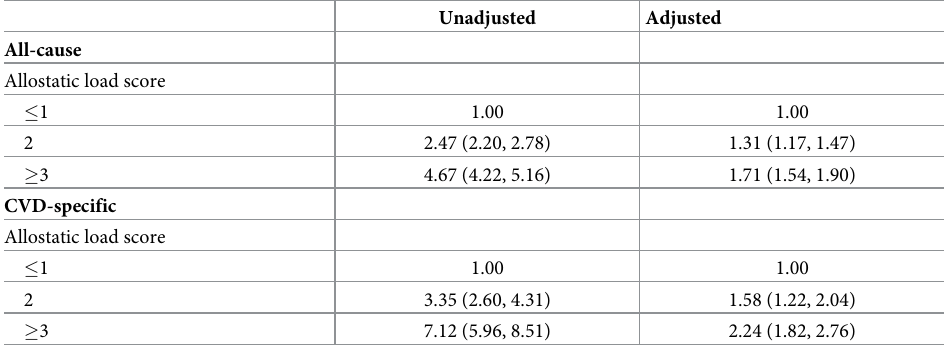
(Table 5). However, these associations were stronger among blacks (HR: 1.80; 96%CI: 1.52, 2.14) and whites (HR: 1.72 96%CI: 1.52, 2.14) than Mexican Americans (HR: 1.47; 96%CI: 1.18, 1.82). For CVD, these associations were only observed among whites and blacks with whites having a greater rate of dying associated with allostatic load scores � 3 than blacks. It is worth noting that an allostatic load score of 2 was associated with all-cause and CVD-specific mortality risk among whites only. When examining racial/ethnic heterogeneity of the associations between allostatic load scores and mortality outcomes according to age, sex and education, no interaction was observed between race/ethnicity, sex and allostatic load scores (p = 0.20) for all-cause mortal- ity; and race/ethnicity, age groups and allostatic load scores (p = 0.42) and race/ethnicity, edu- cation, and allostatic load score (p = 0.62) for CVD-specific mortality. However, we observed interactions between race/ethnicity, age groups and allostatic load score (p = 0.03) and race/ ethnicity, education and allostatic load score (p = 0.02) for all cause-mortality; and race/ethnic- ity, sex and allostatic load score (p = 0.03) for CVD-specific mortality. Table 4. Crude and adjusted hazard ratios a of all-cause and CVD-specific mortality risk for allostatic load score categories: NHANES III-Linked Mortality File,